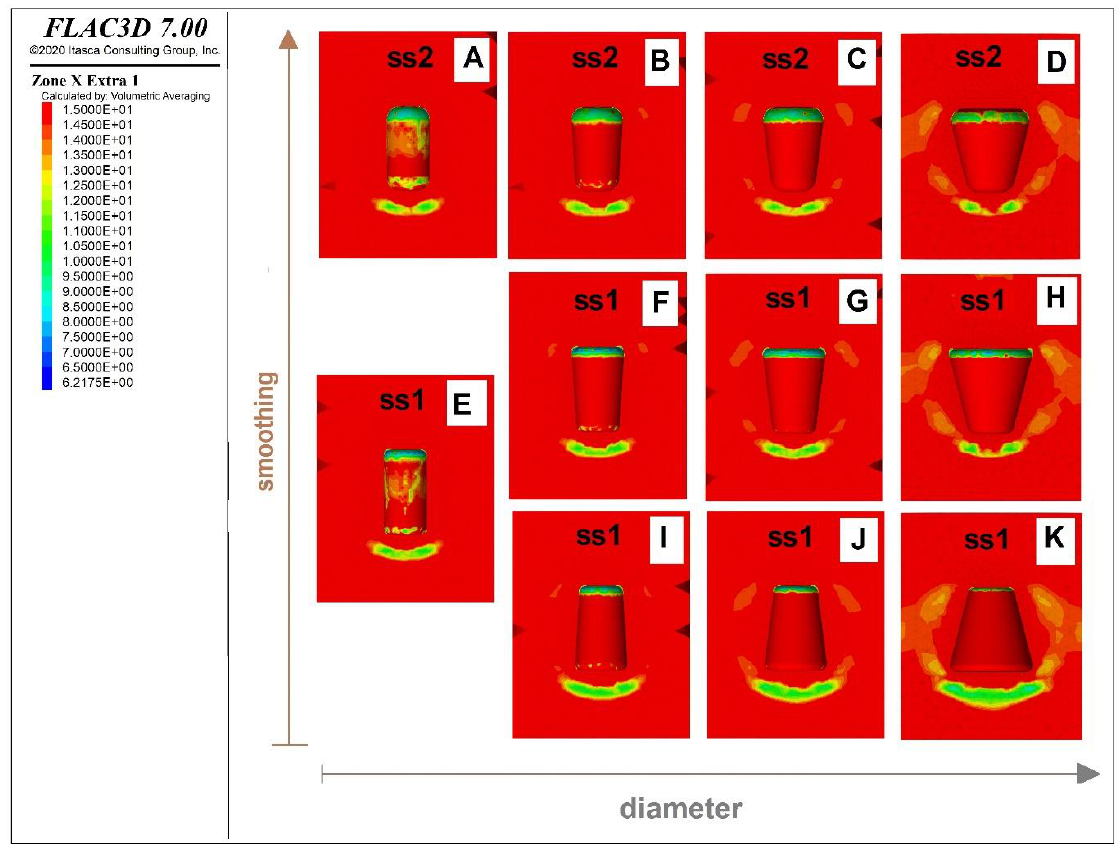
Figure 20. The SF distribution in caverns with ss1; the last injection period: ( A , E ) cylindrical, ( B , F , I ) maximum initial diameter of 75 m, ( C , G , J ) maximum initial diameter of 90 m, ( D , H , K ) maximum initial diameter of 120 m.